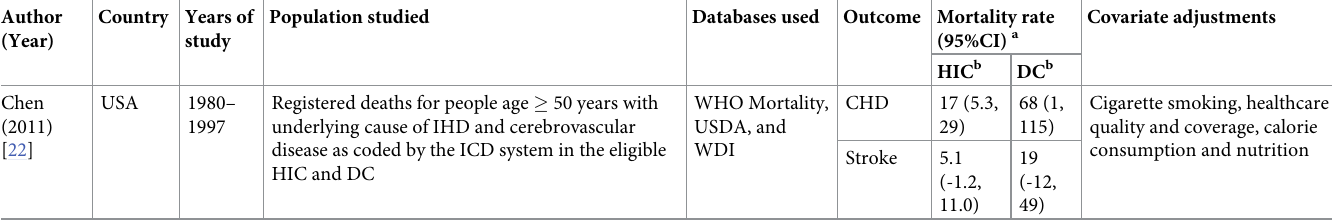
Table 3. Risk estimates of association of palm oil consumption and CVD-related